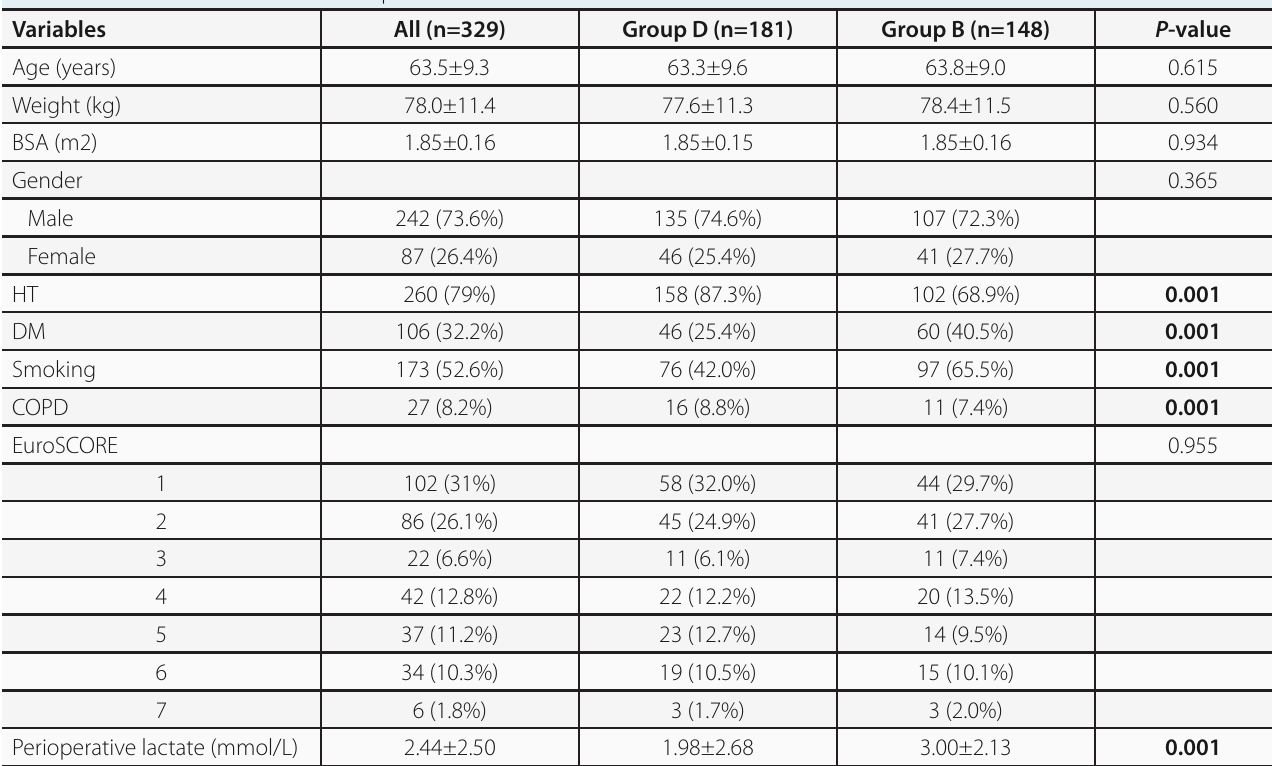
Table 1. Baseline characteristics of the